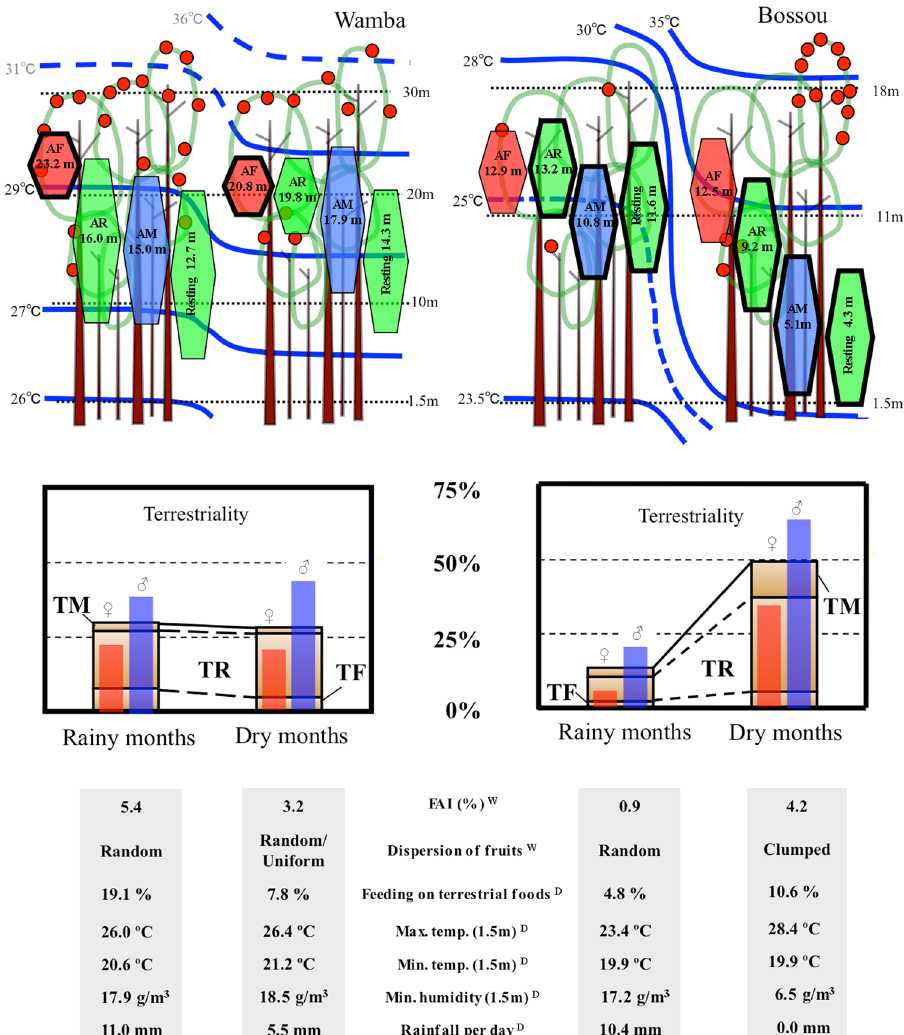
Figure 1. Scheme of the seasonal relationship between forest environments and utilization height or terrestriality in chimpanzees and bonobos. Upper: Seasonal changes in fruit availability and estimated air temperature contour lines. Broken lines mean alternative values were used when actual measurements were lacking (see Methods). Utilization heights were represented by height relative to the canopy where the forest microclimate was measured. Each vertical length of behaviour reflects the standard deviation. Behaviours surrounded by thick lines showed significant seasonal differences in each site. Middle: Time spent for terrestrial behaviour (%). Lower: Averages of environmental factors in each research period. AF: Arboreal feeding, AR: Arboreal resting, AM: Arboreal moving, Resting: Arboreal and terrestrial resting (AR + TR), D: Average of daily values, W: Every two-weeks’